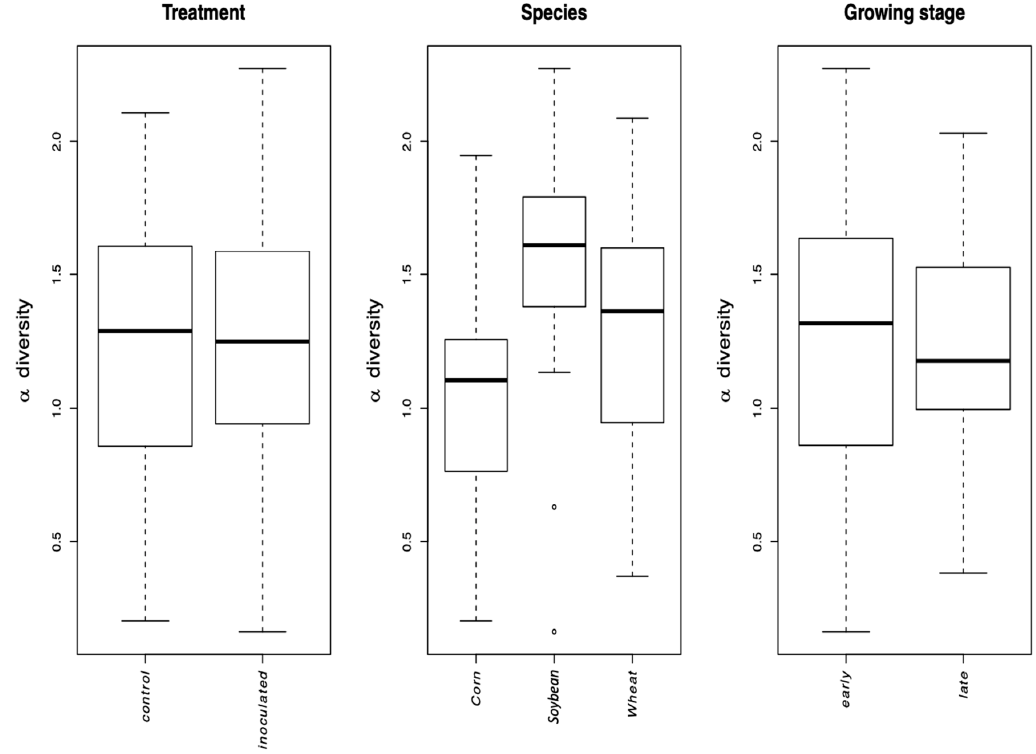
Figure 4. Simpson diversity of virtual taxa (VT) of the different inoculation treatments, crop plant, species, and growth stages. Crop species and growth stage had a significant effect on diversity. Median values and interquartile ranges are shown in the plots.